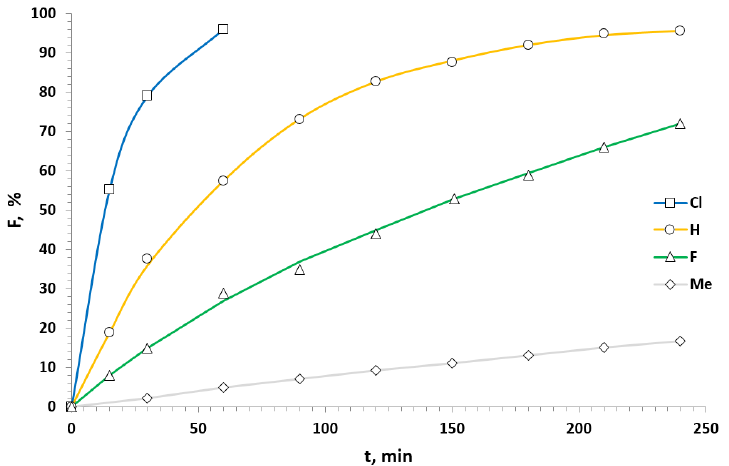
Figure 4. Kinetic curves of the reactions of differently β -substituted nitrostyrenes with pyrrole at 50 ◦ C.